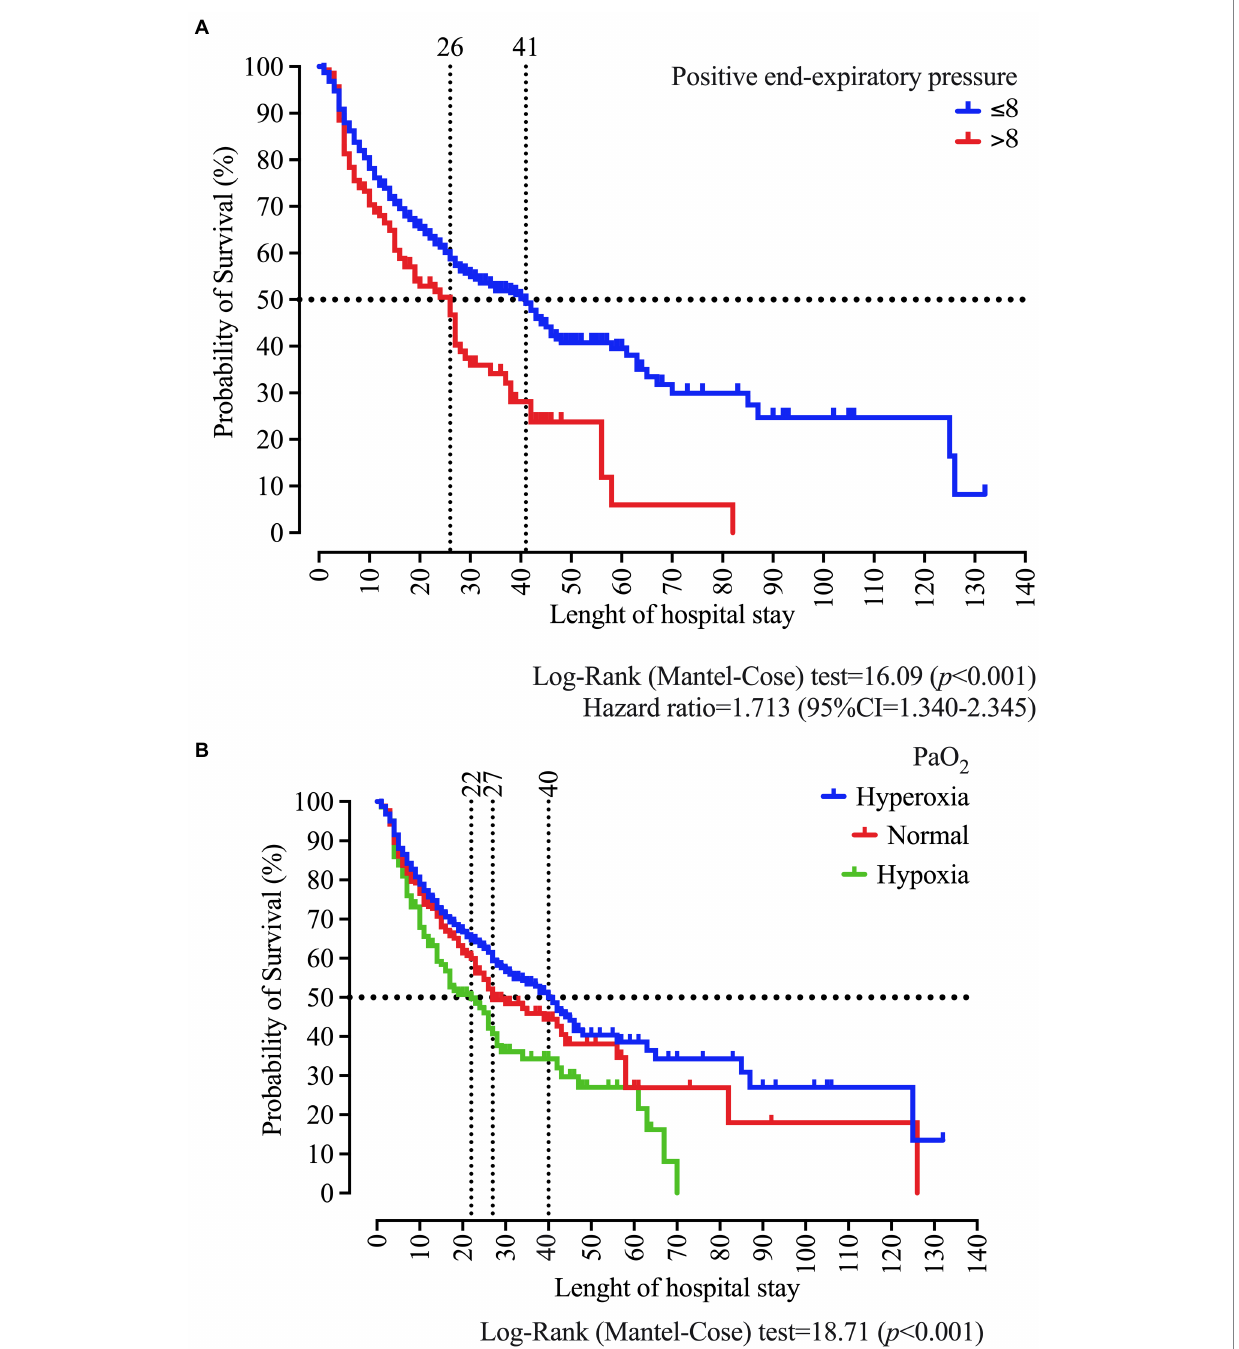
FIGURE 7 Survival curve of patients who were intubated at the University Hospital according to the positive end-expiratory pressure (PEEP) (A) , and the arterial oxygen pressure (PaO 2 ) classification as normal, hypoxemia, and hyperoxemia (B) . We carried out the statistical analysis using the Log-Rank (Mantel-Cose) test. We calculated the Hazard ratio using the PEEP ≤ 8 cmH 2 O as the numerator parameter and we adopted a 0.05 alpha error. PaO 2 values at admission in the ICU were categorized using the following distribution: hypoxia (<80 mmHg), normal (between 80 and 100 mmHg), and hyperoxia (>100